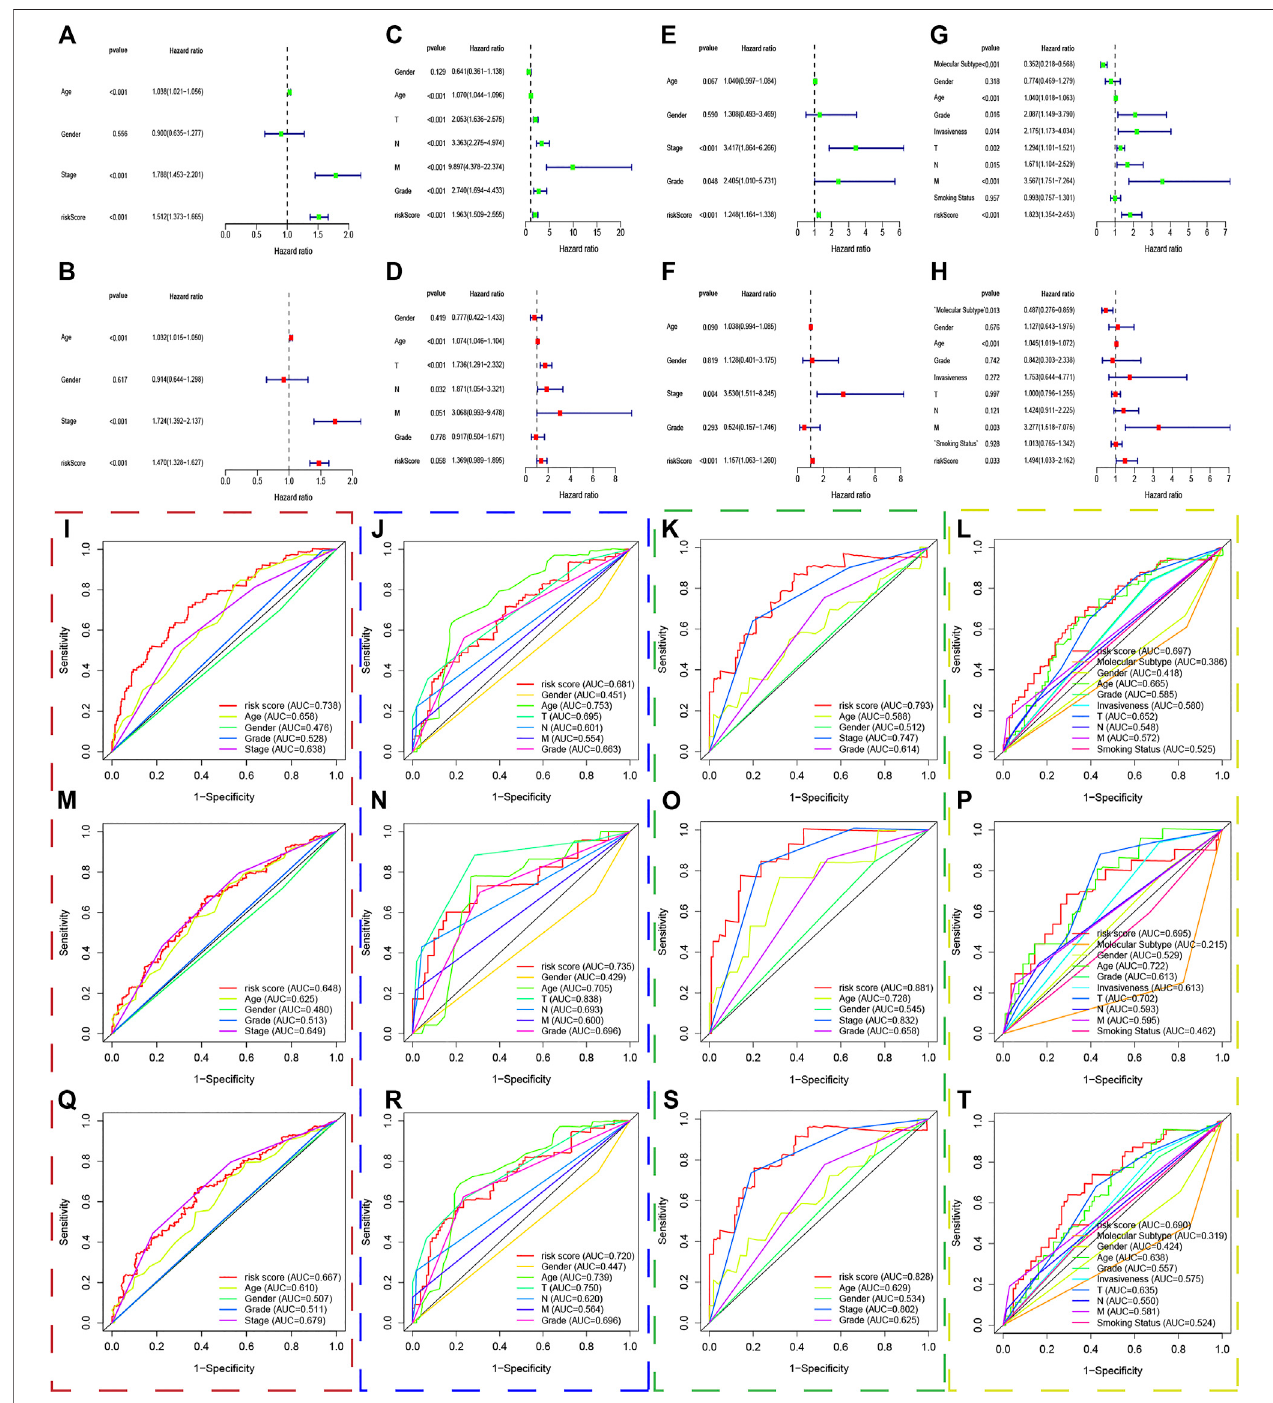
FIGURE7| Thepredictiveperformanceoftheriskscoreandotherclinicopathologicalparameters. (A – H) TheunivariateandmultivariateCoxregressionsuggested that the risk score was an independent prognostic factor in the training and validation sets. The red, blue, green, and yellow dashed boxes corresponded to the TCGA, GSE13507, GSE32548, and GSE48075, respectively. I , J , K, and L showed that the 1-year multiple ROC curves of the risk score and other clinicopathological parametersinthetrainingset,GSE13507,GSE32548,andGSE48075,respectively. M , N , O, and P showedthatthe3-yearsmultipleROCcurvesoftheriskscore and otherclinicopathologicalparametersinthetrainingset,GSE13507,GSE32548, andGSE48075,respectively. Q , R , S, and T showedthatthe5-yearsmultipleROC curves of the risk score and other clinicopathological parameters in the training set, GSE13507, GSE32548, and GSE48075, respectively.